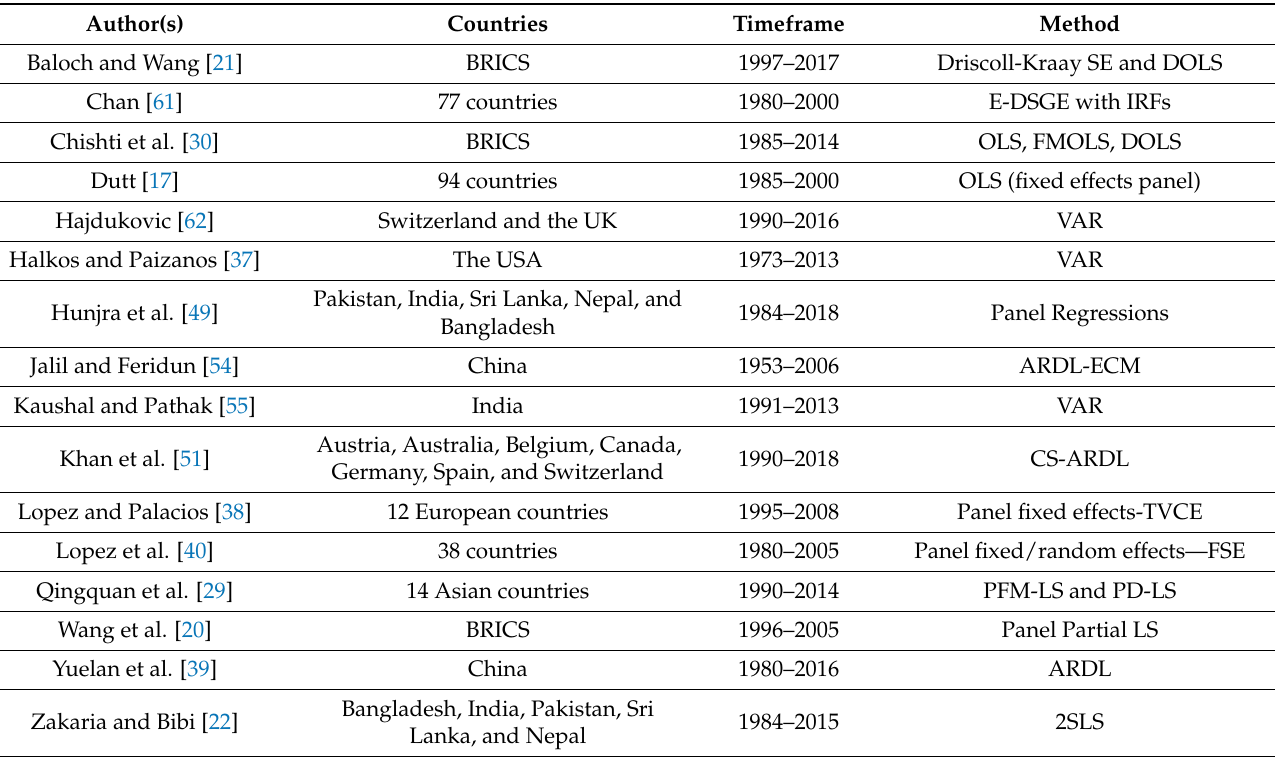
Table 1. Core literature